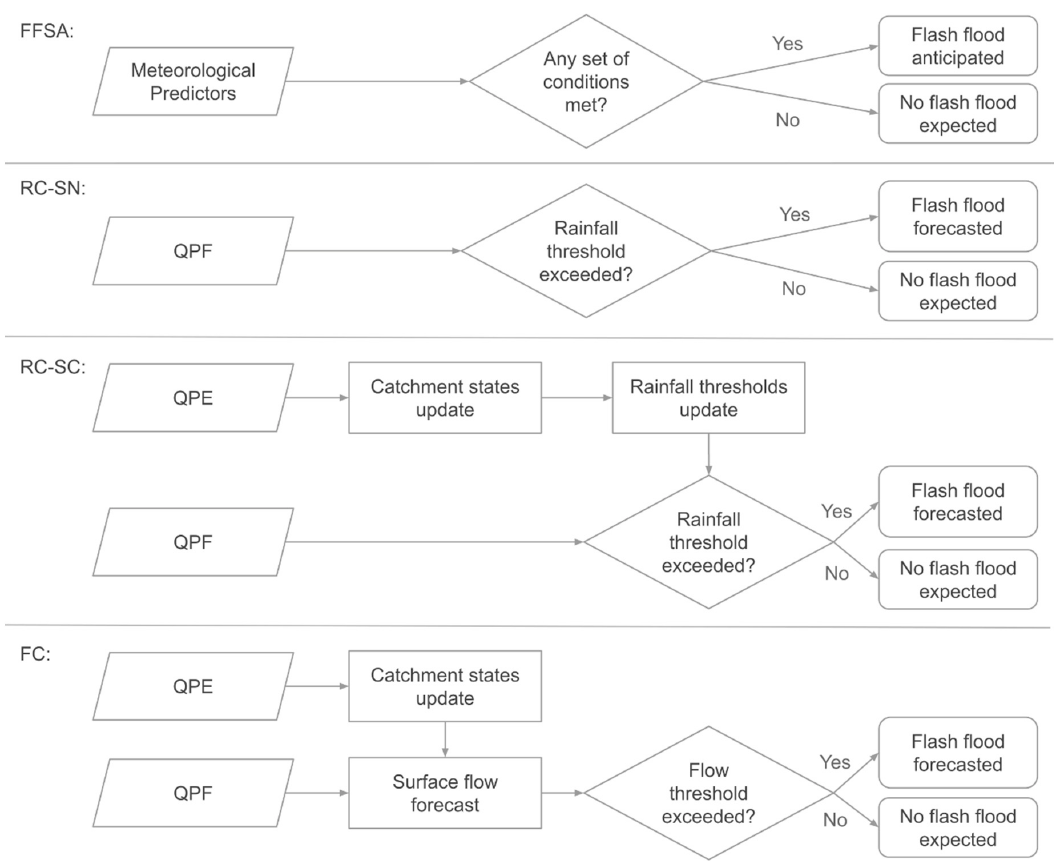
Figure 2. Overall workflows adopted by the different decision approaches usually present in flash flood early warning systems (FFEWS). FFSA, flash flood susceptibility assessment; RC-SN, rainfall comparison with surface conditions neglected; RC-SC, rainfall comparisons with surface conditions considered; FC, flow comparison; QPF, quantitative precipitation forecast; QPE, quantitative precipitation estimations.